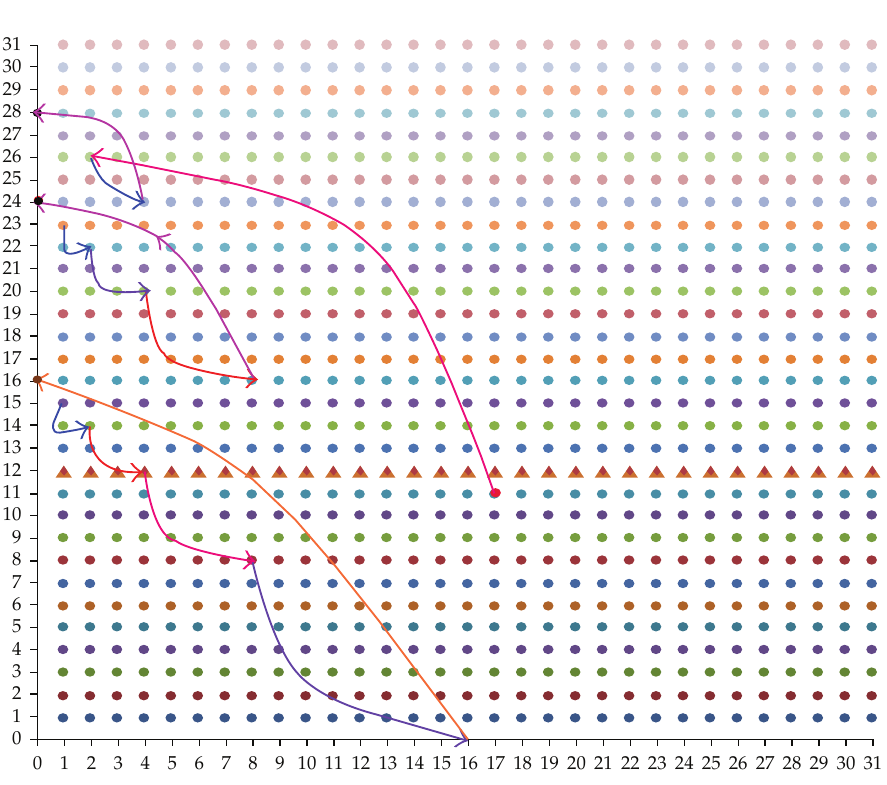
Figure 3: Showing the state transition diagrams (cid:2) STDs (cid:3) of three order pairs (cid:2) 1 , 23 (cid:3) , (cid:2) 1 , 15 (cid:3) , and (cid:2) 17 , 11 (cid:3) as shown in Table